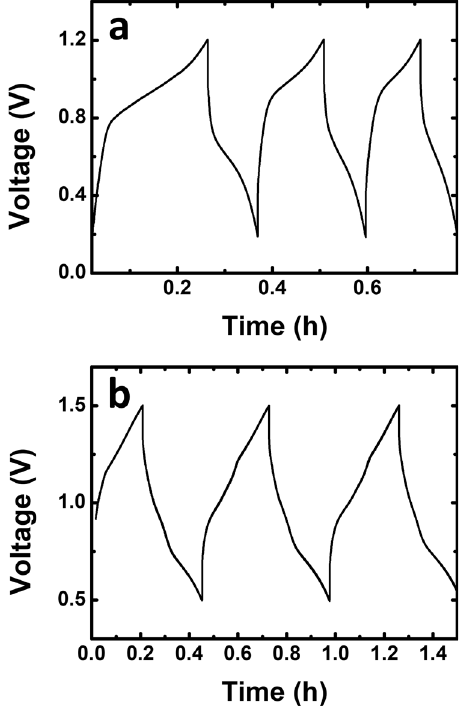
Fig. 5 Charge – discharge cycling performance. Representative